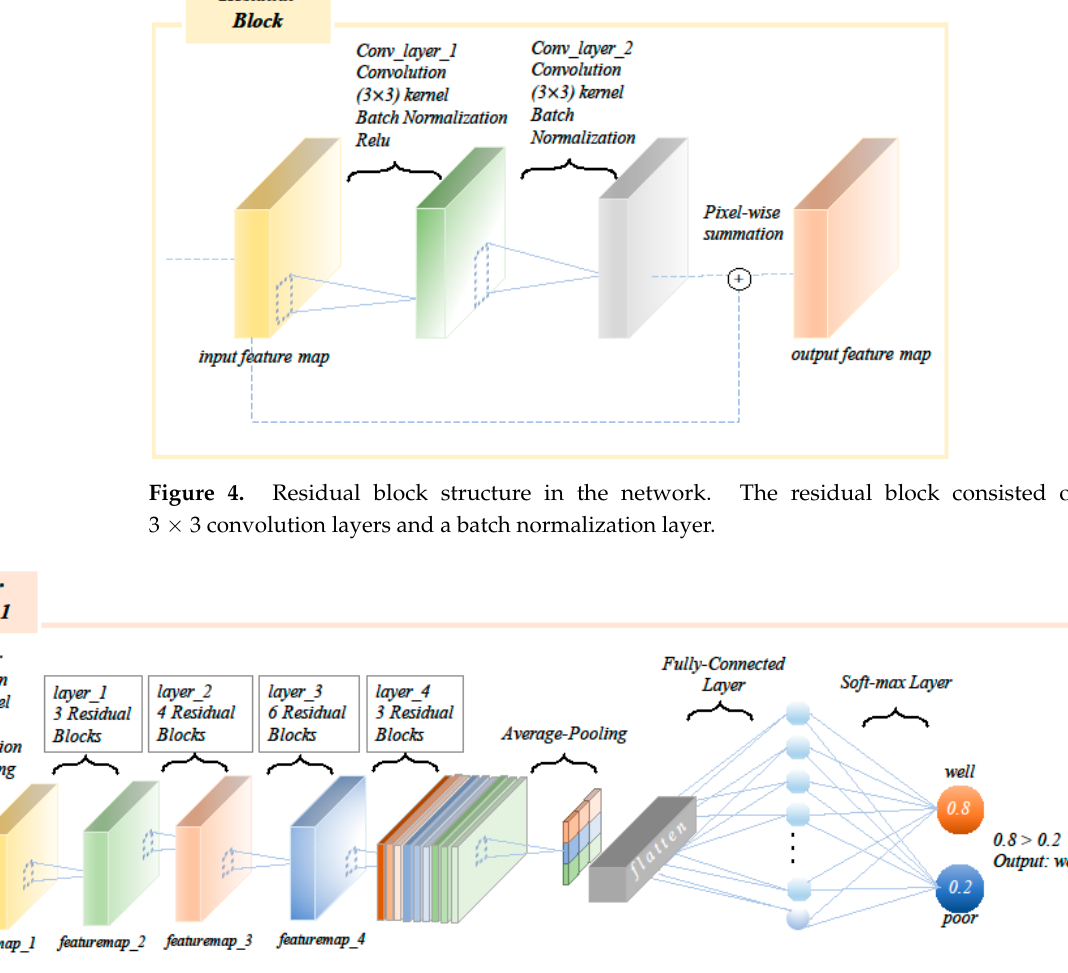
6 of 15 Figure 3. Example of a patient with good collateral circulation. Note: the M1 segment of the right middle cerebral artery of the patient was occluded (the yellow arrow), and there were many collat- eral vessels in the blood supply area (the yellow dashed box) of the right middle cerebral artery in A (arterial phase), A-V (arteriovenous phase), V (venous phase), and d-V (venous late phase). 2.5. Model Construction and Training We tried the commonly used classification networks, VGG, Densenet, ResNet34, etc., and finally chose the ResNet34 as it had the best classification effect. The Adam optimizer